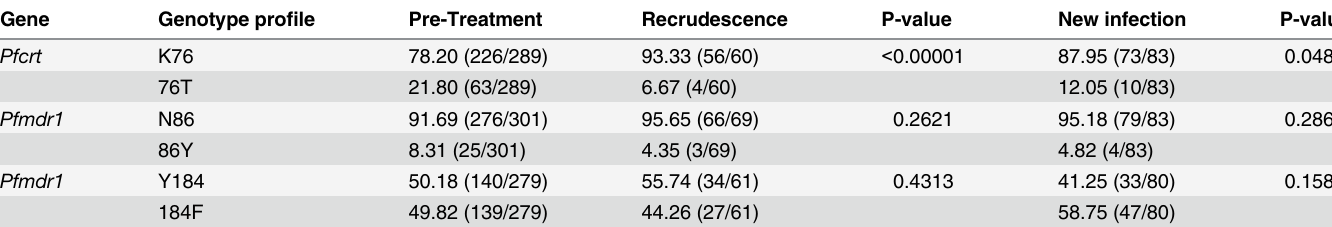
Table 1. Prevalence of Pfcrt and Pfmdr1 alleles before and after treatment with AL % (n/N). Gene Genotype pro fi le